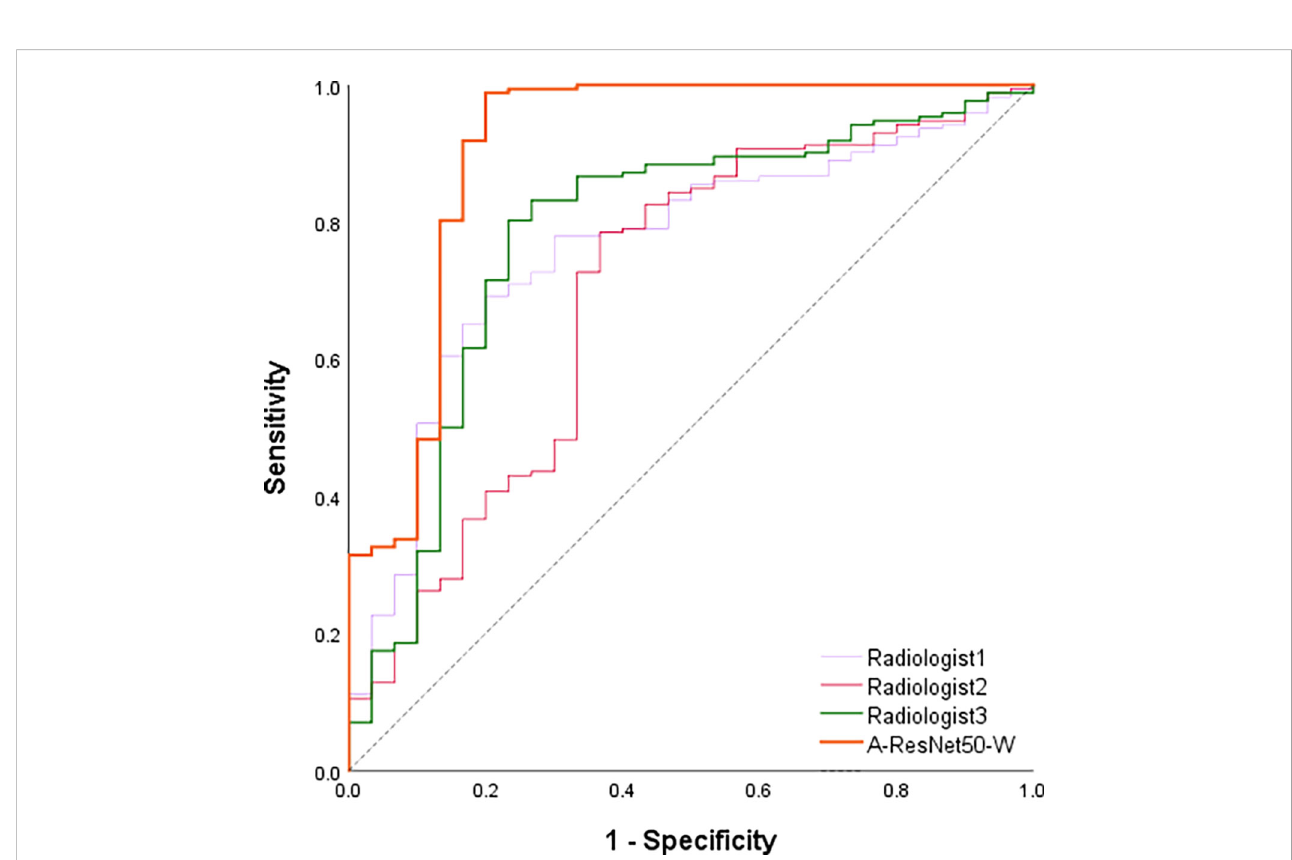
FIGURE 9 The classi fi cation performance of cervical LNM using CT images for different